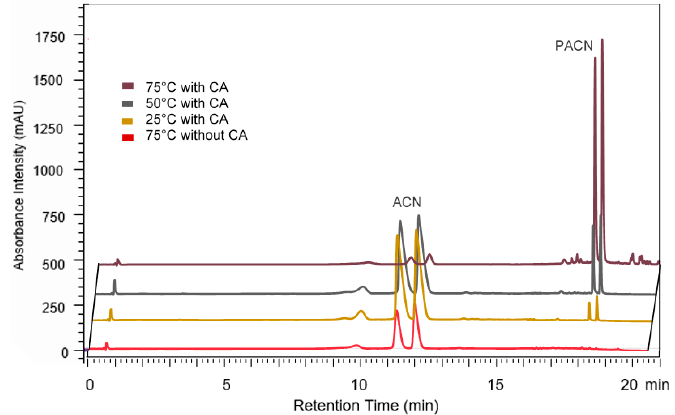
Figure 2. Retention time of two main anthocyanins (ACN) and pyranoanthocyanins (PACN) obtained from sample incubated for 24 h at 75 °C with and without caffeic acid (CA), 50 °C with caffeic acid, and 25 °C with caffeic acid. Chromatograms viewed between 500 and 520 nm. uHPLC-PDA-MS/MS settings were as described in Figure 1.